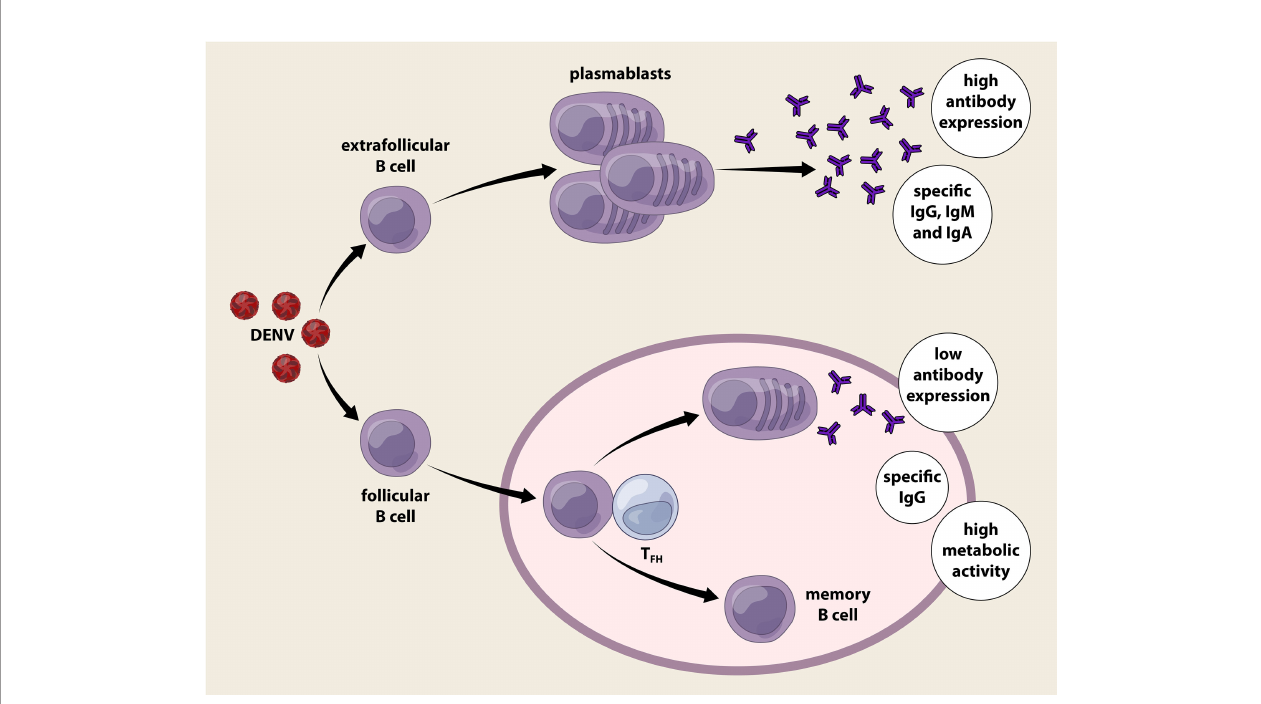
FIGURE 3 | T-dependent and T-independent plasmablast reactions elicited by dengue infection. Dengue virus infection activates B cells directly or indirectly, expanding the B cells into a vast number of circulating plasmablasts. Plasmablasts that are derived from extracellular B cells proliferate rapidly in an innate manner without the requirement of T cell help. The Immunoglobulin gene of this plasmablast population is hypomutated as it lacks germinal centre reaction and produces IgM, IgG and IgA. T-independent plasmablasts response vigorously during acute dengue infection regardless of primary or secondary infection. On the other hand, follicular B cells activated receive help from follicular helper T cells (T FH ) and initiate the germinal centre reaction where clonal expansion, class switch and active somatic hypermutation (SHM) occurred. The plasmablast produced are long lived and predominant antibodies released are of IgG isotype. Surprisingly, these plasmablasts with evidence of T cell help secrete poor levels of antibodies compared to those without T cell help, but present with high oxidative phosphorylation, eukaryotic initiation factor (EIF2) pathway, and mitochondrial dysfunction. Memory B cells generated following dengue infection provides long term protection after